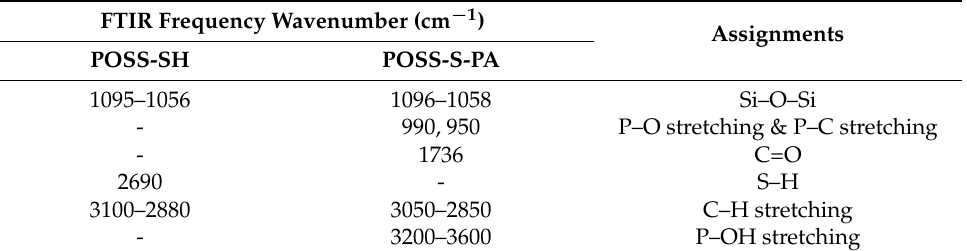
Table 1. Peak positions and its corresponding assignments of POSS-SH and POSS-S-PA